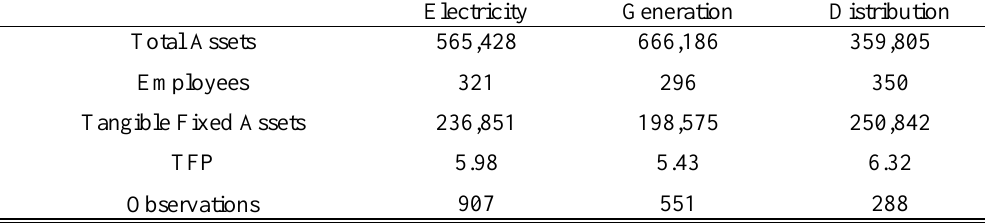
Table 1: Firm-Level Descriptive